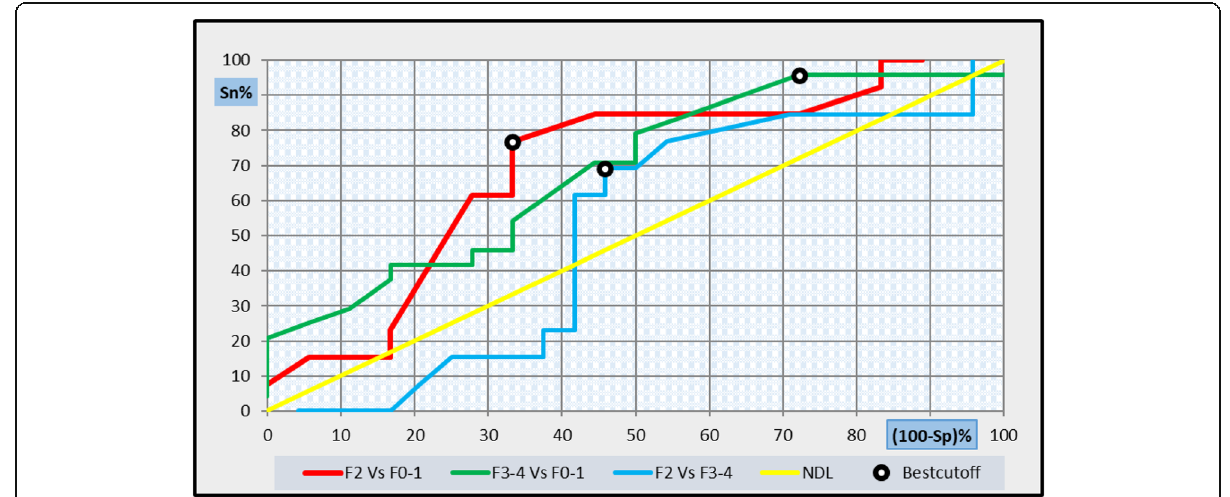
Fig. 7 ROC curve analysis showing the diagnostic performance of GDF-15 for discriminating patients of different patients ’